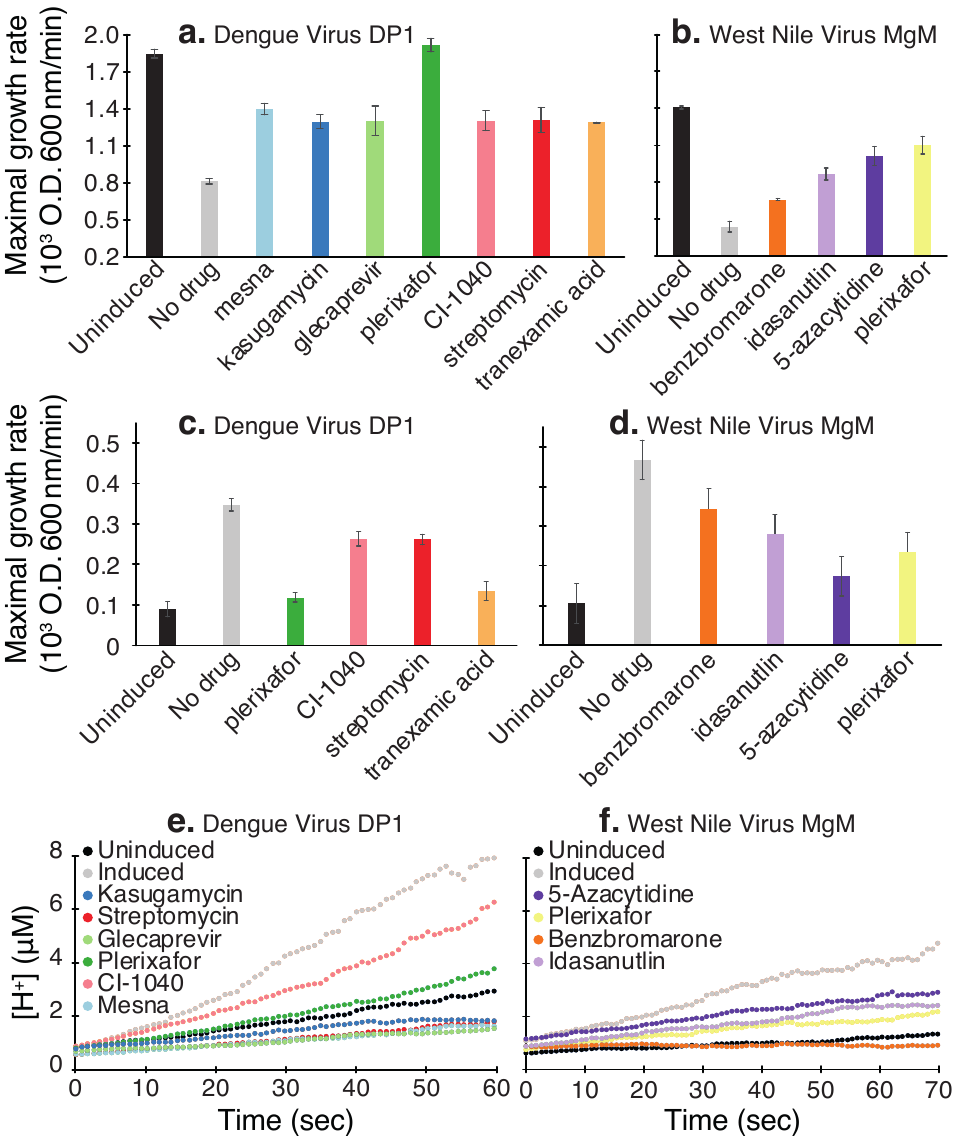
Figure 4. Blocker screening results against Dengue Virus DP1 and West Nile Virus MgM viroporins. The negative assay results are depicted in panels a and b, the results from the positive assay are presented in panels c and d, and finally the acidity assay results are presented in panels e and f. Bacteria in which the channel expression was not induced or the drug was not added are used as controls. Blocker concentration was 50µM.